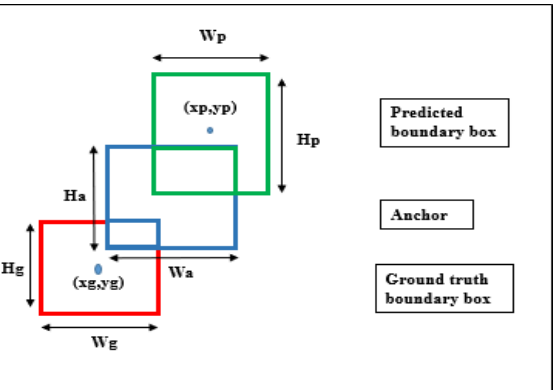
Figure 5. Geometrical representation of ground truth box, predicted box, and an anchor